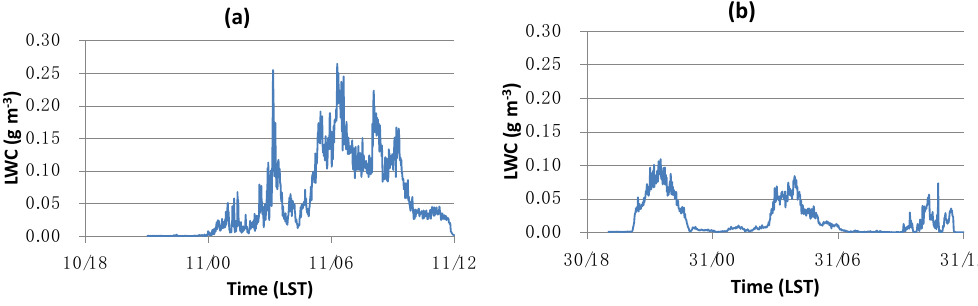
Figure 13. Observed liquid-water content (LWC) at coast site A (MMSEB) of the two sea-fog cases (Plotted are 1 min averages of 1 s data). ( a ) Case 1. ( b ) Case 2.